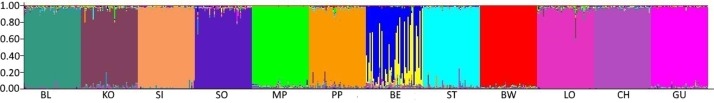
Bar plot of Bayesian analysis of population structure (K = 14) showing the proportion of individual fish’s membership that was assigned to their source populations and to other populations, and the probability of admixture with other populations.